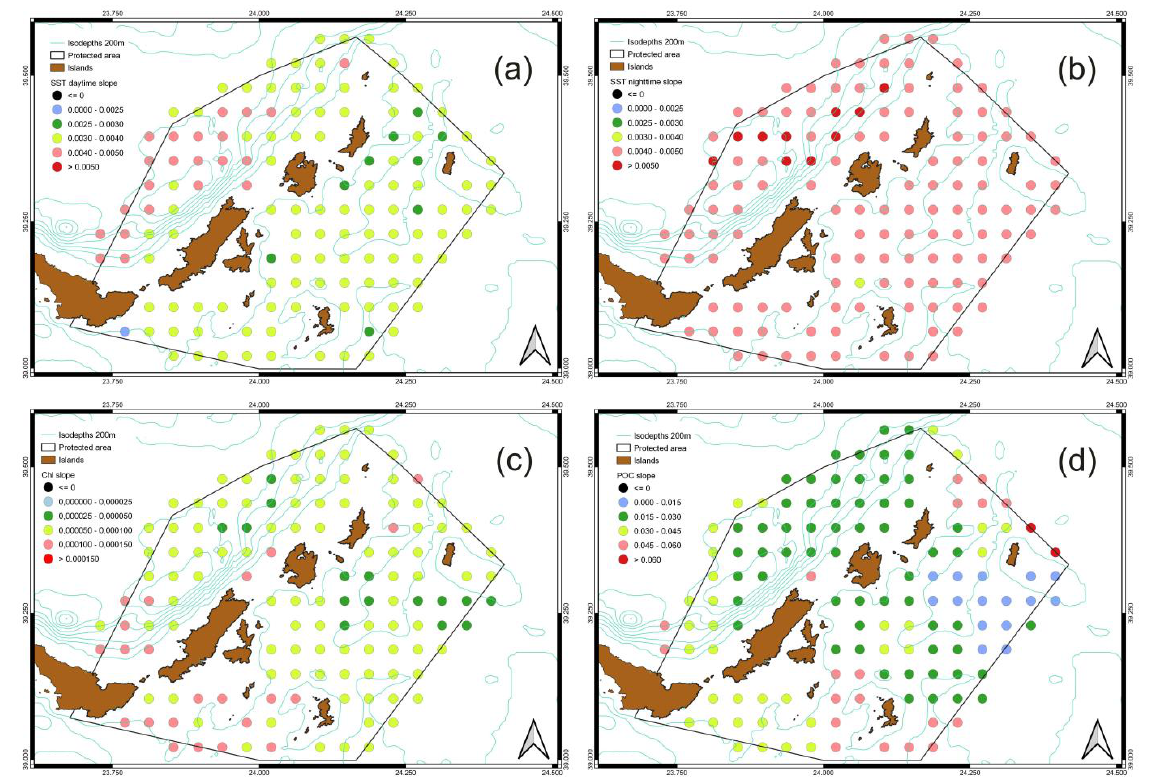
Figure 6. Spatial variability of slope from 2000 to 2020 for ( a ) daytime SST, ( b ) night-time SST, ( c ) Chl-a and ( d ) POC. Each point corresponds to the center of the pixel. The average monthly SST slope during daytime shows that lowest values usually occur during the cold season (winter – autumn), while in warm season (summer – spring) it the highest values of SST slope are observed, especially in the northwest part of the MPA.